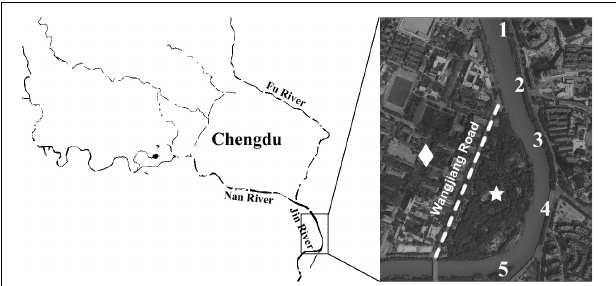
FIGURE 1 | Illustration of sampling efforts. The numbers along the river marked the sites of water sampling. The star indicates the position of Wangjianglou Park, while the diamond indicates the Wangjiang campus of Sichuan University. The dashed line labels the Wangjiang Road that separates the park and the